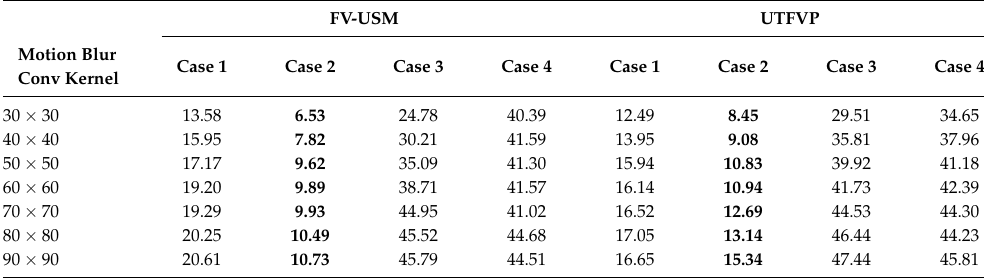
Table 3. EERs (%) of FV-USM and UTFVP with different motion blur kernels. FV-USM UTFVP Motion Blur Case 1 Case 2 Conv Kernel